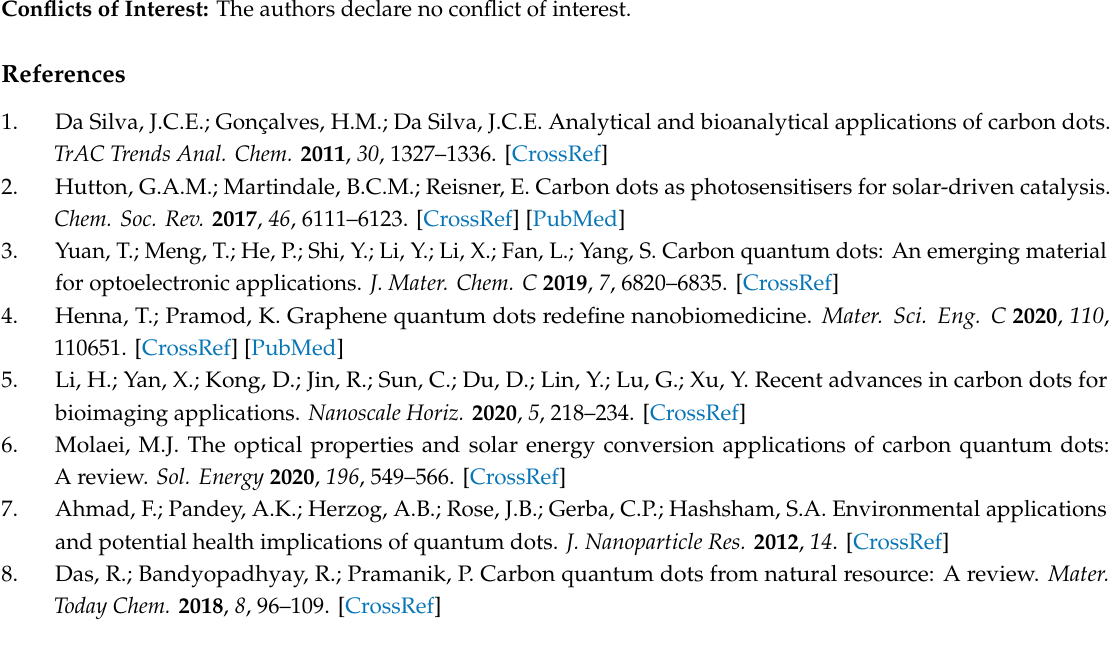
Figure S2: Deconvolution of a typical PL spectrum of purified O-CDs, Figure S3: PL spectra and peak positions as a function of λ exc , of W-CDs synthesized at 70 ◦ C after purification; Table S1: Summarized spectroscopic data of the CD